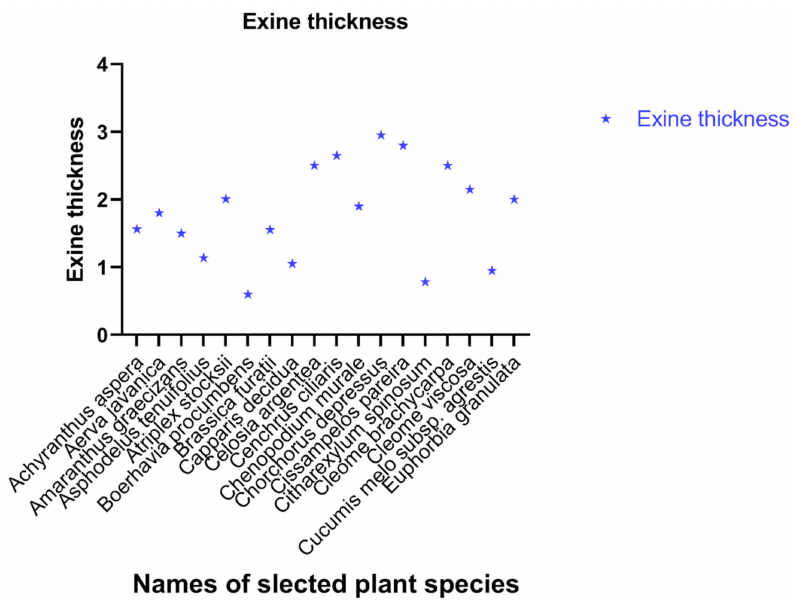
Figure 8. Graph representing the exine thickness of the selected plant